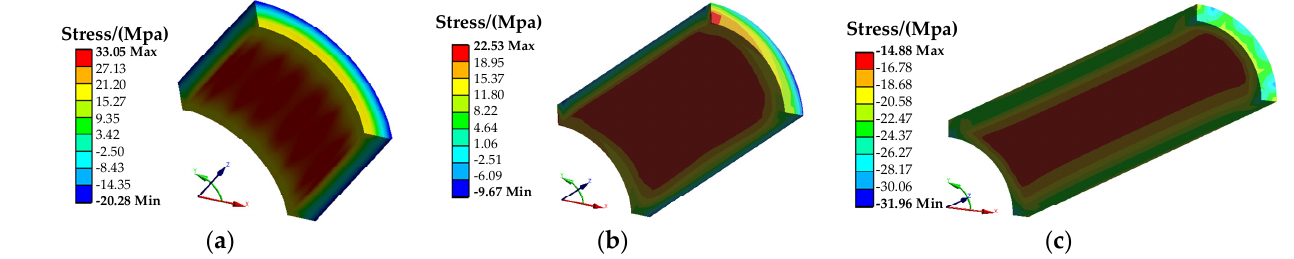
Figure 20. Permanent magnets radial stress distribution under the three cases at rated speed at a cold state: ( a ) Case 1; ( b ) Case 2; ( c ) Case 3.